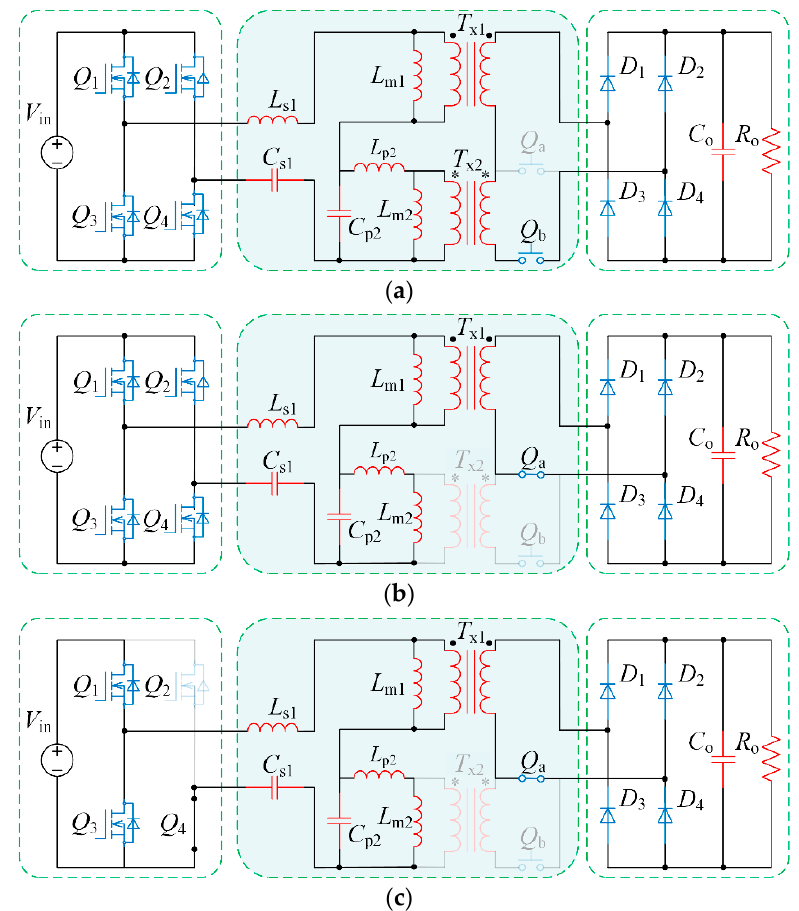
Figure 4. Three different working modes of the proposed converter. ( a ) Full bridge (FB) CLTCL; ( b ) FB-LCLCL; ( c ) half bridge (HB) LCLCL. ( b ) FB-LCLCL; ( c ) half bridge (HB)